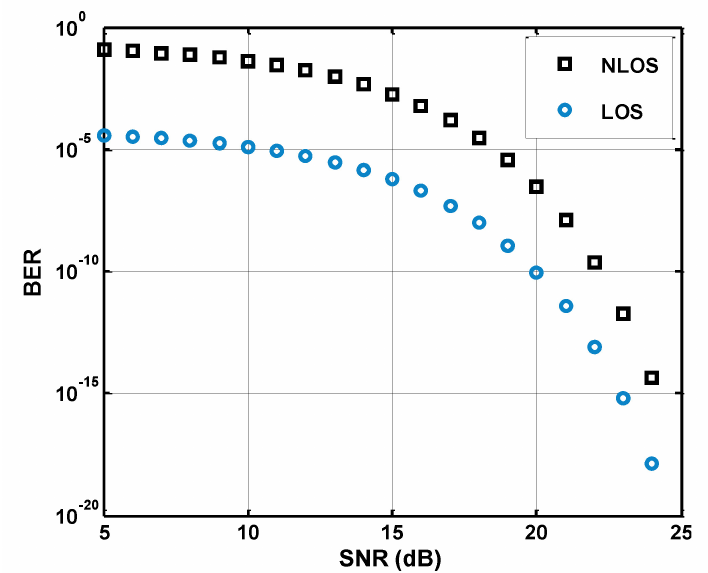
Figure 10. Signal-to-noise ratio and bit error rate analysis for LOS, and NLOS